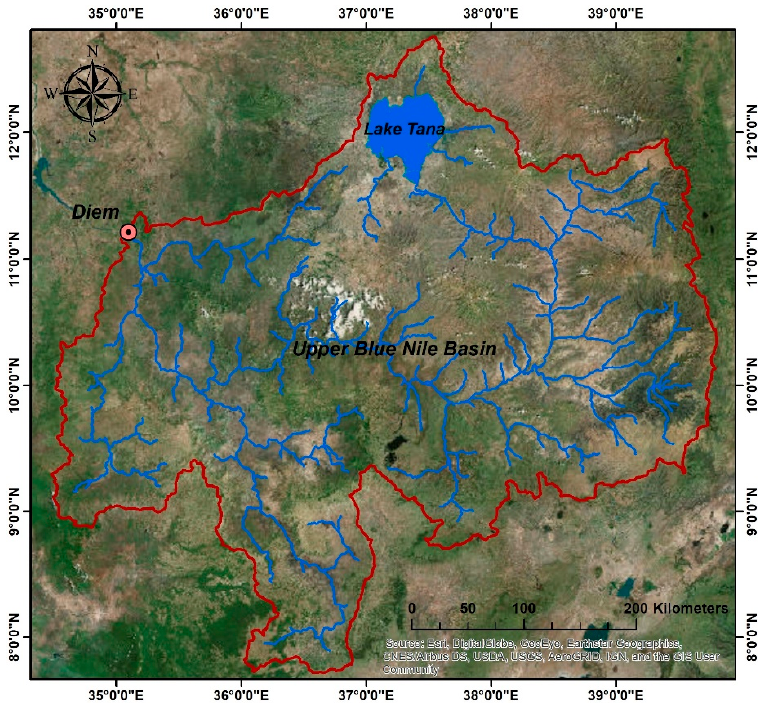
Figure 3. Upper Blue Nile basin map.